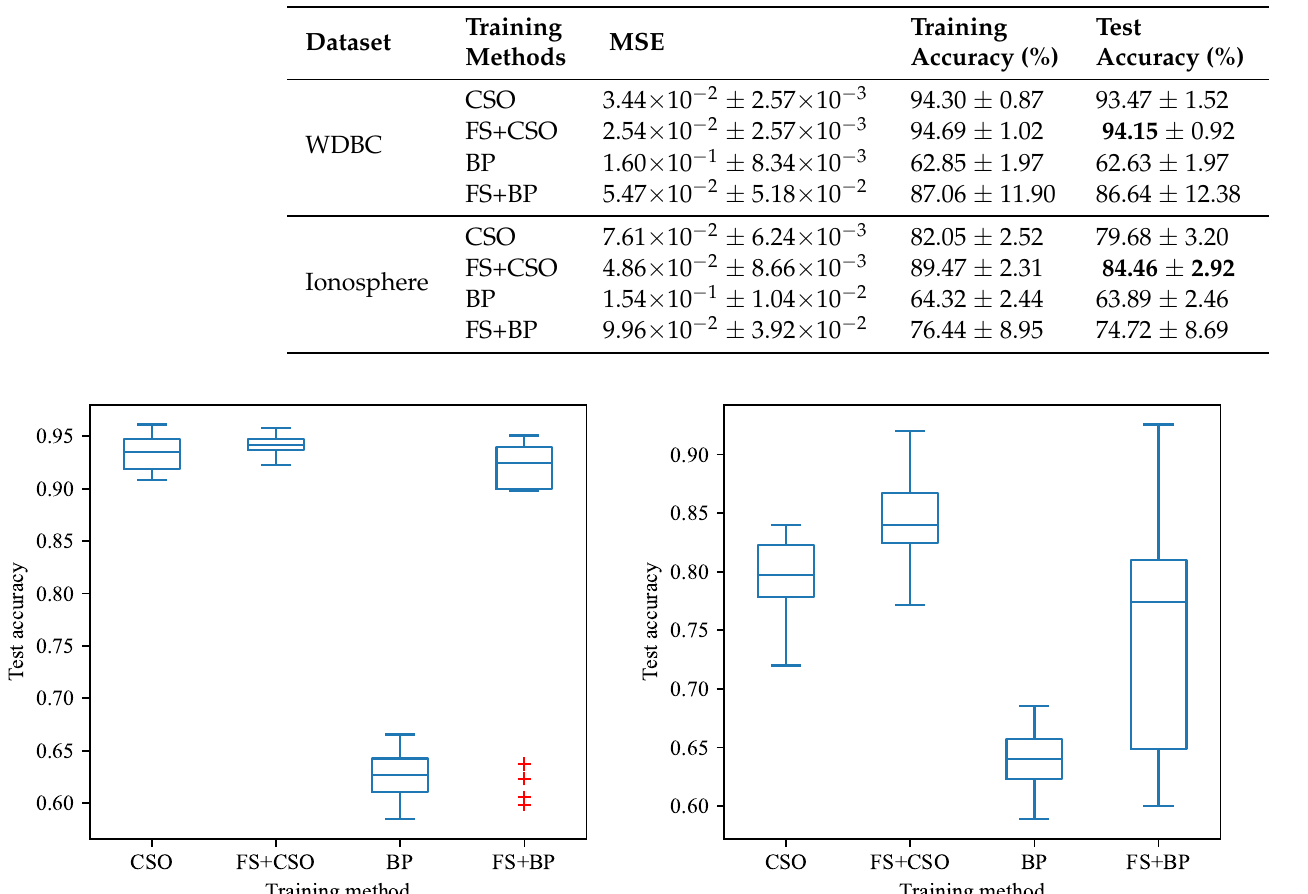
Table 2. The statistical results of four training methods for two problems.